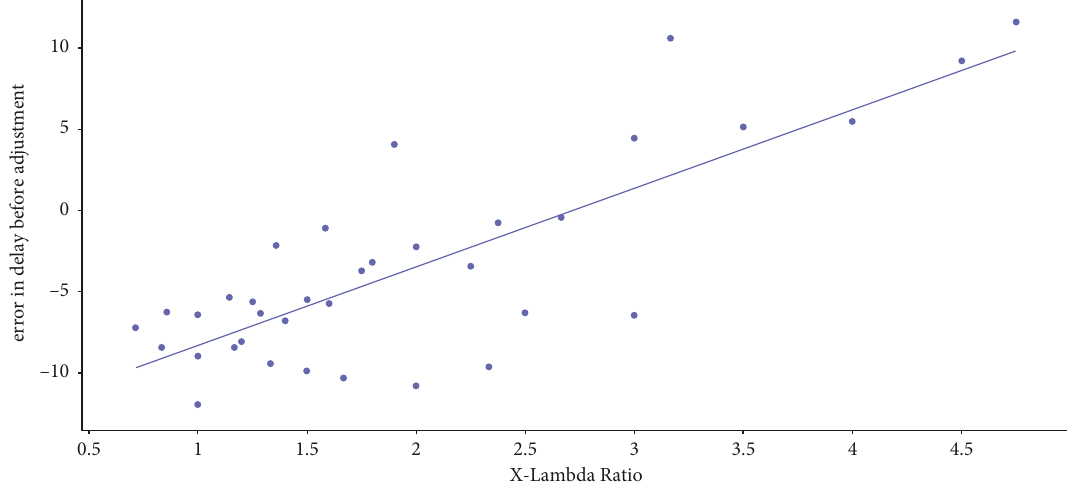
Figure 9: Variation of errors in delay estimates with X / λ ratio.